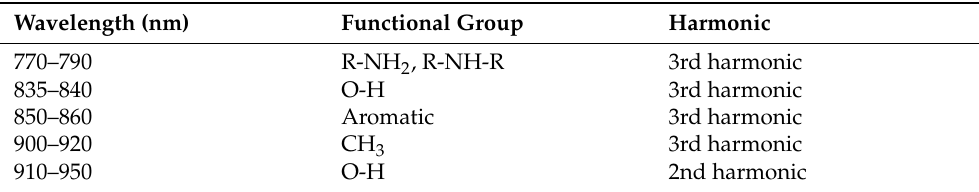
Table 2. The functional groups in EBN are denoted by the wavelength of VIS/SW-NIR bands and their respective harmonic